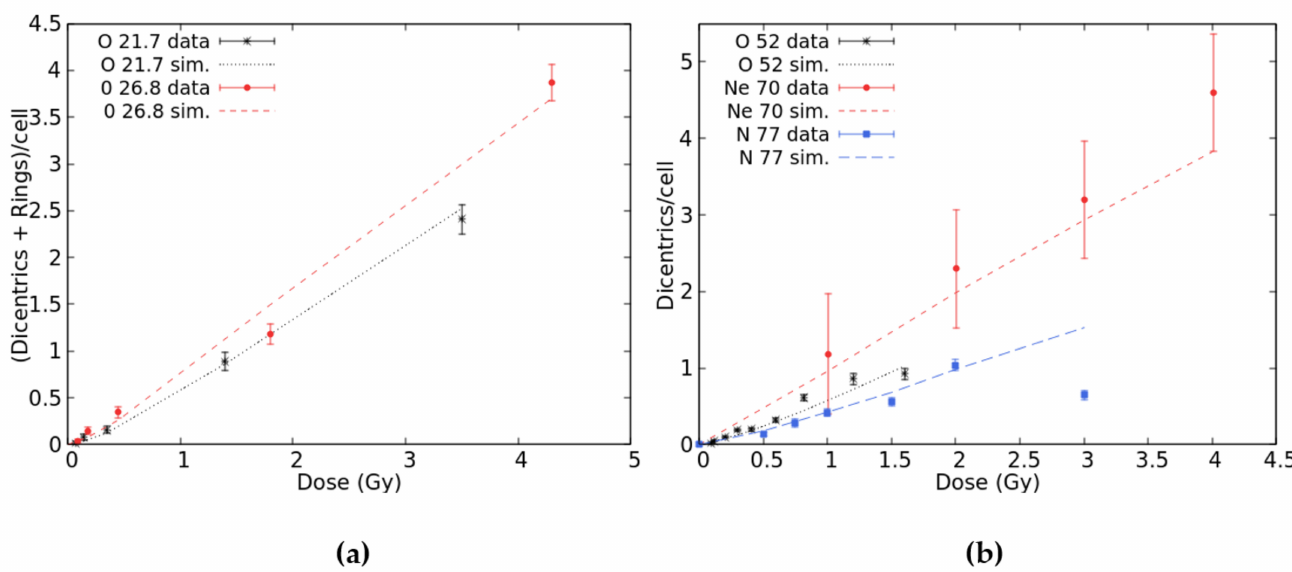
Figure 4. Mean number of dicentrics plus rings per cell versus dose-induced by 21.7 and 26.8 keV/ µ m O-ions (panel a ) and mean number of dicentrics per cell versus dose-induced by 52 keV/ µ m O-ions, 70 keV/ µ m Ne-ions, and 77 keV/ µ m N-ions (panel b ). The points with error bars are experimental data, and the lines are simulation